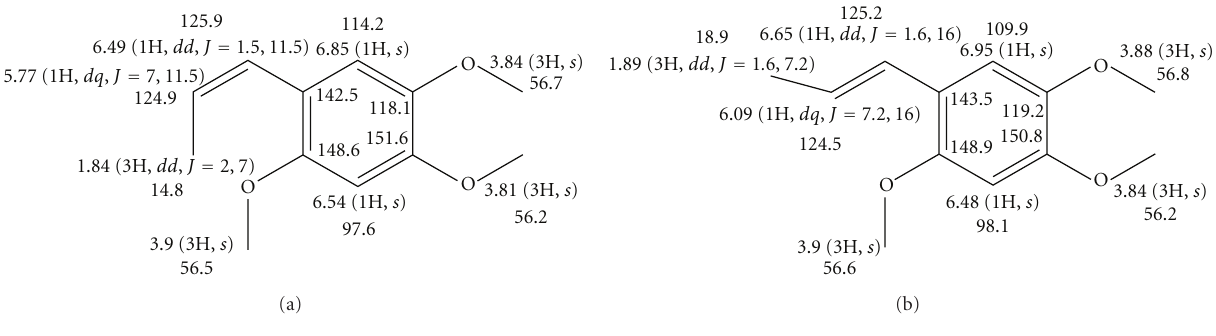
Figure 4: Chemical structures for cis- asarone (a) and trans- asarone